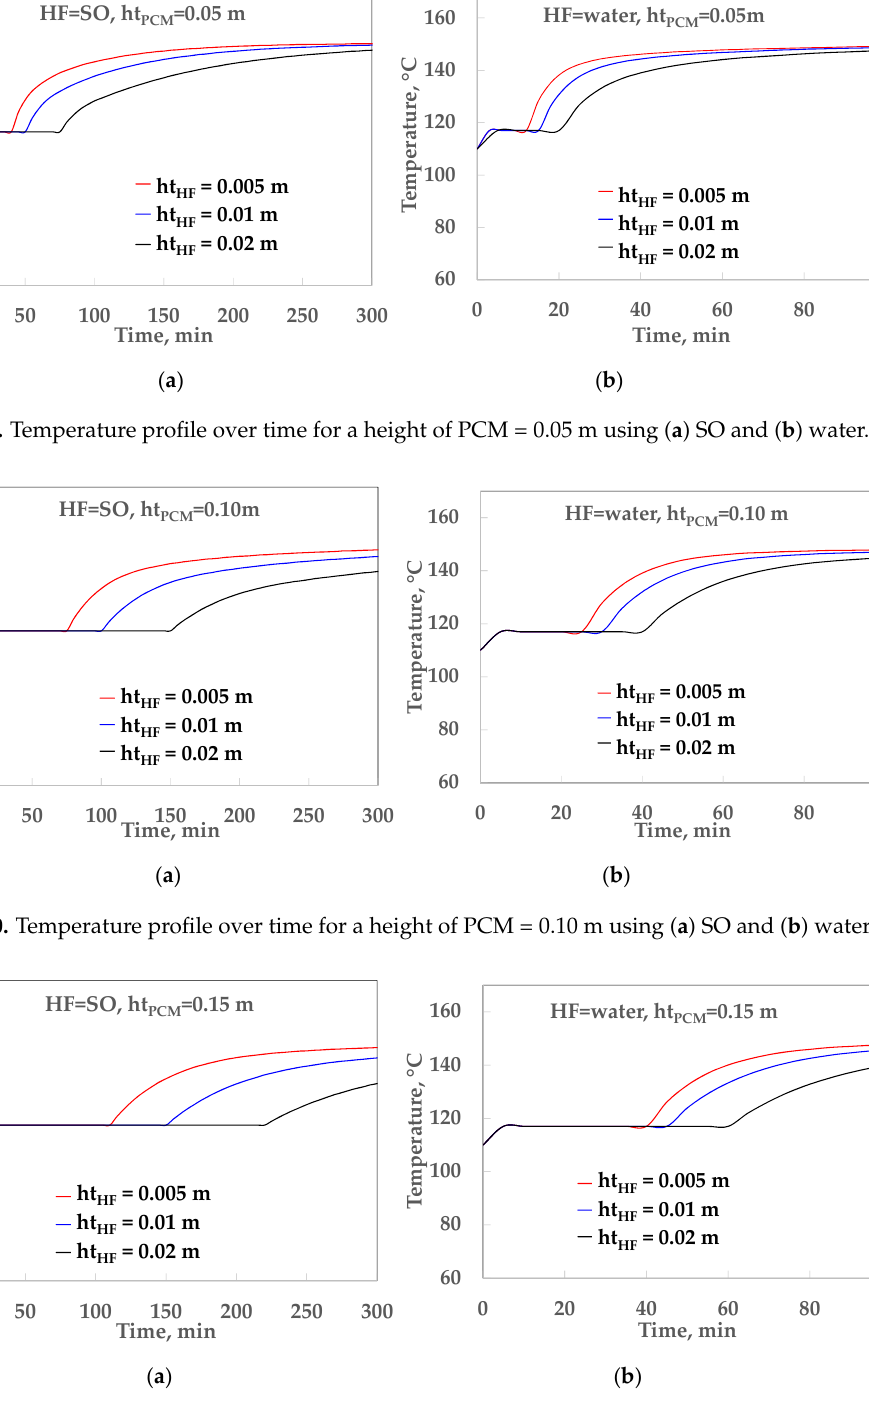
Figure 11. Temperature profile over time for a height of PCM = 0.15 m using ( a ) SO and ( b ) water. It was observed that water requires less phase change time than SO, due to the ther- mal resistance (TR) in the heating fluid. Table 5 shows the thermal resistances inside the LHST at different ht PCM at a flow rate of 1200 kg/min, which corresponds to a convection transfer coefficient (h HF ) of 0.09 and 0.52 kW/m 2 °C for SO and water, respectively. It can be seen that the global heat transfer (U) is almost doubled when ht PCM is 0.05 m for SO